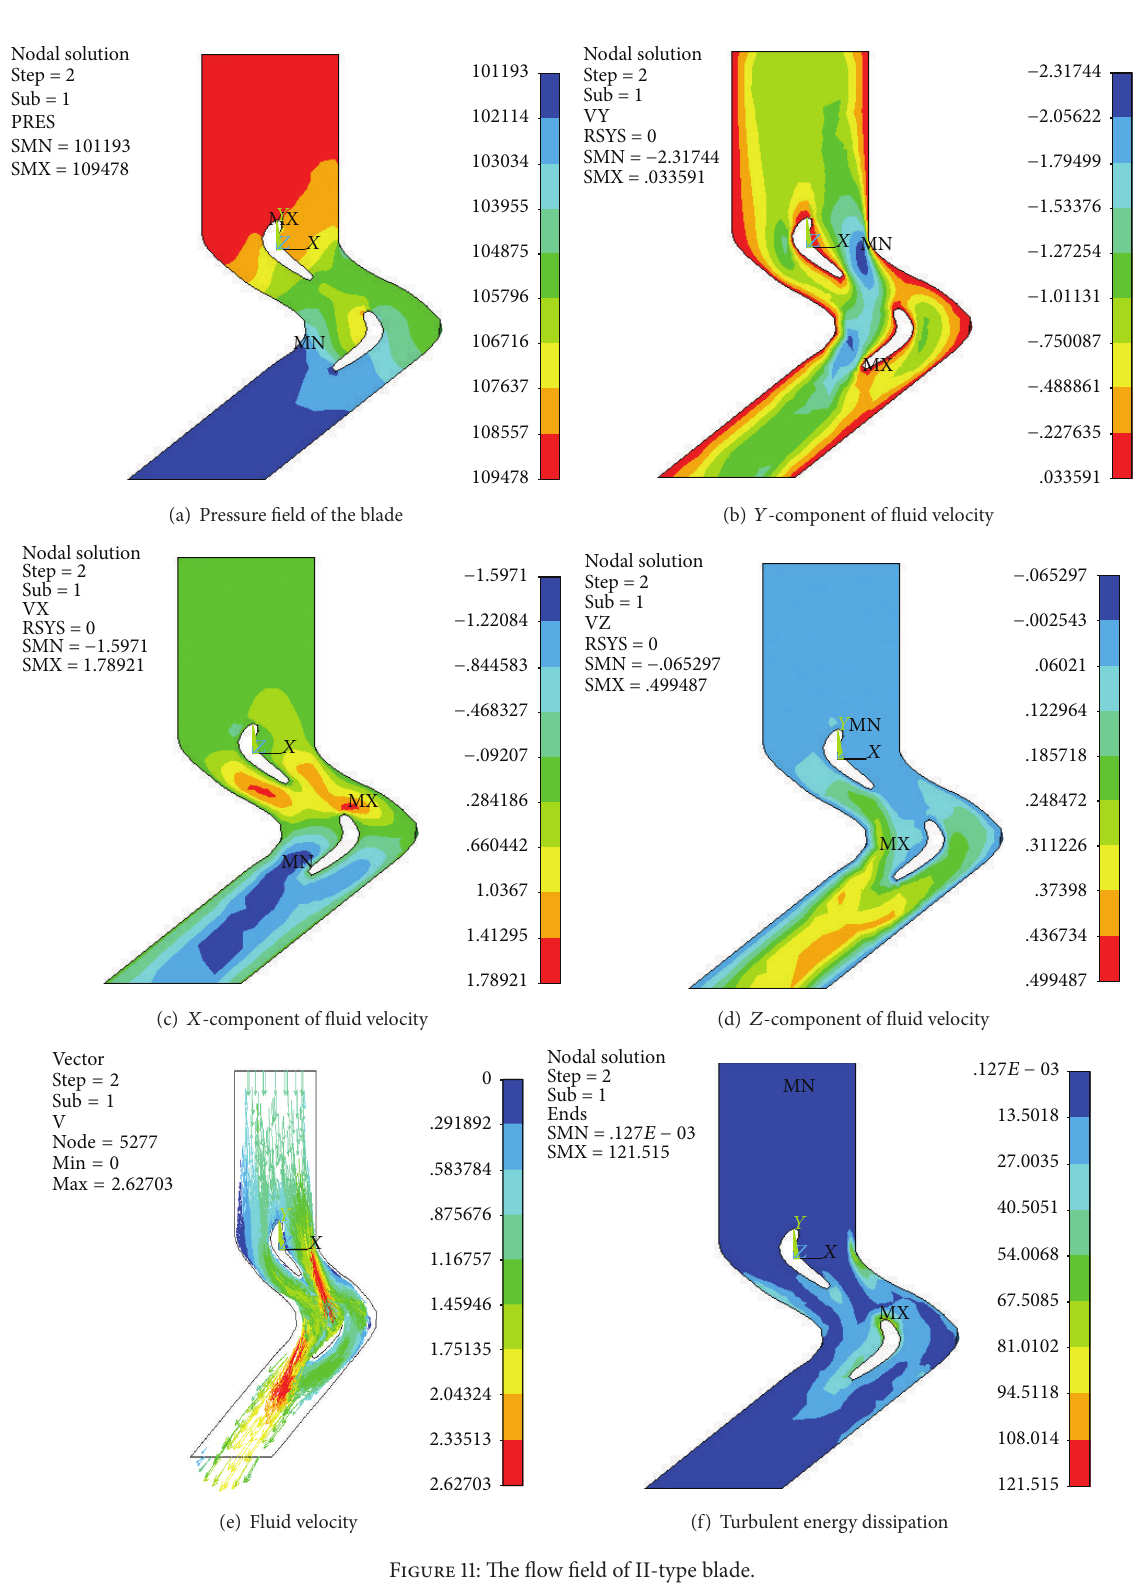
Figure 11: The flow field of II-type